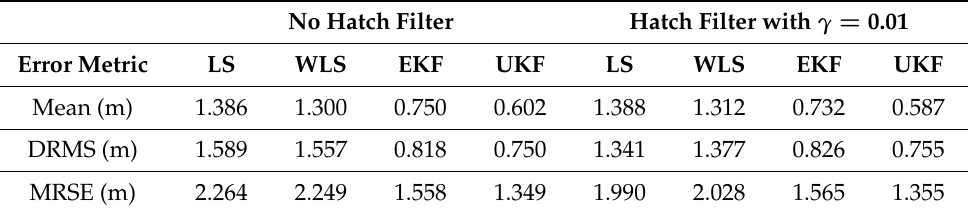
Table 2. Error metrics for 24 h position survey of the base station antenna. No Hatch Filter Hatch Filter with γ = 0.01 Error Metric